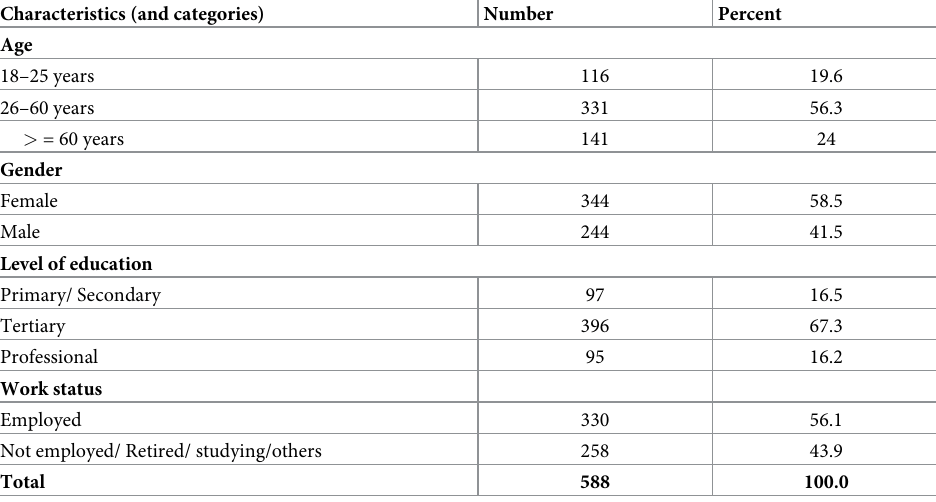
Table 1. Summary of the socio-demographical data of the